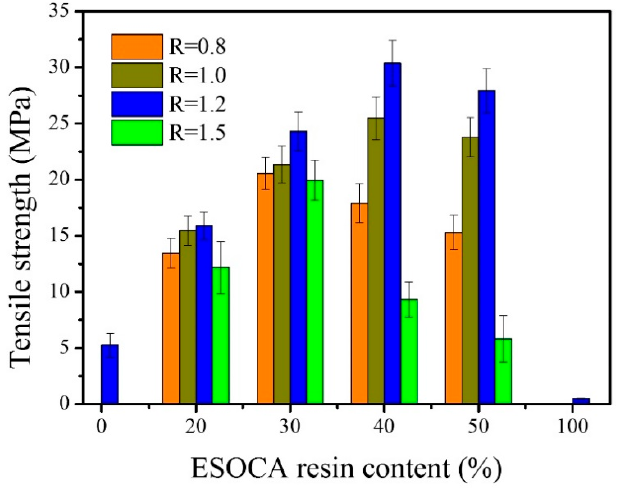
Figure 5. Tensile strength of SEC biocomposites with different R values and ESOCA resin content.